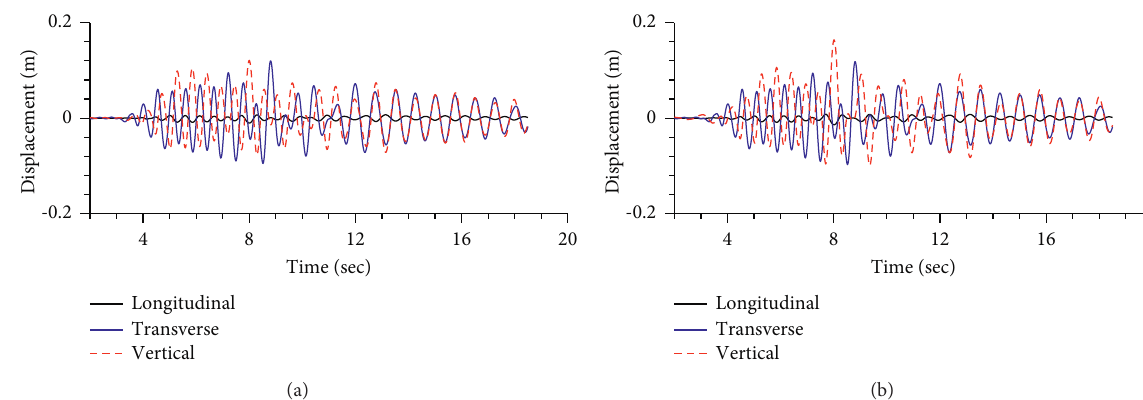
Figure 8: Time history of the midspan displacement of the long span. (a) Bidirectional excitation. (b) Tridirectional excitation.